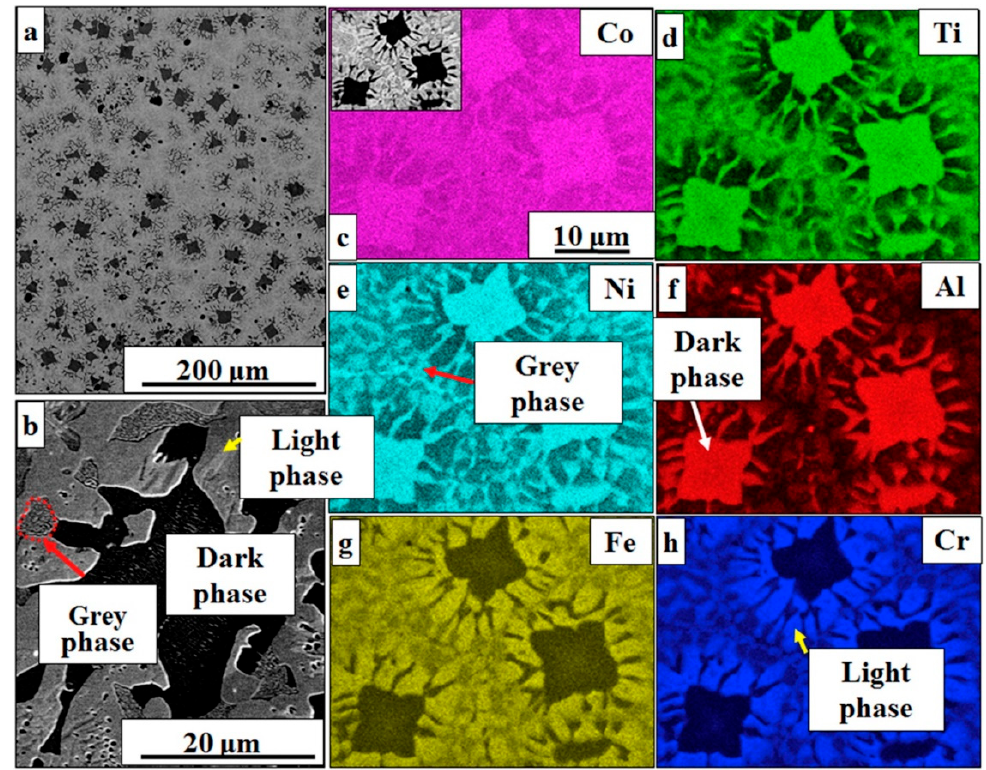
Figure 29. Scanning electron microscope images of Al 0.25 CoCrFeNiTi 0.75 alloy in as-cast